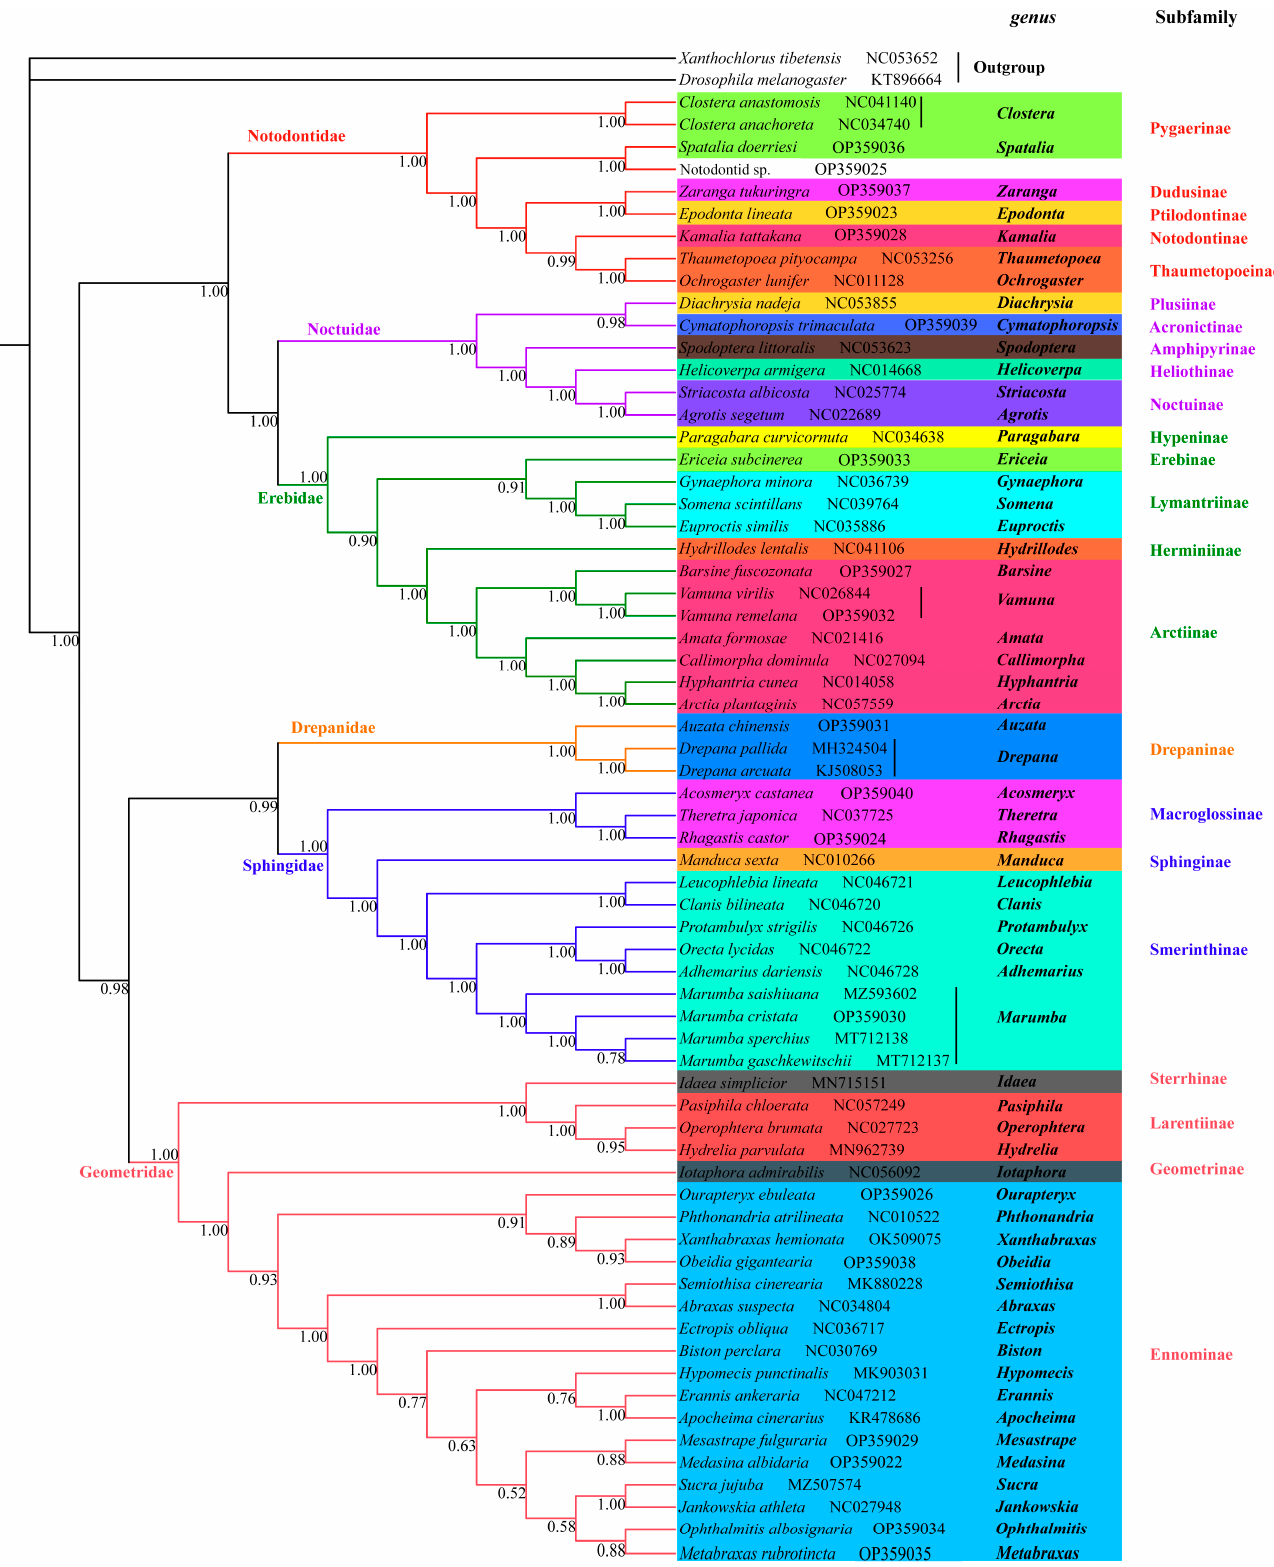
Figure 7. Phylogenetic tree inferred from nucleotide sequences of 13 PCGs using the BI analysis. Numbers on the branches are BI posterior probability.